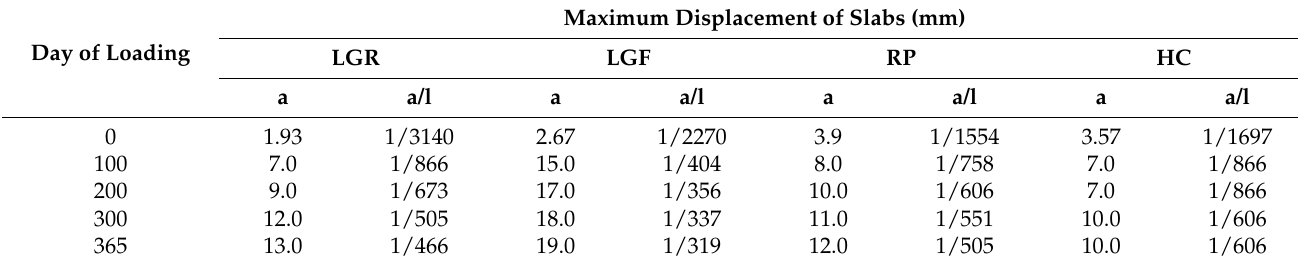
Table 5. Maximum displacements of individual models on consecutive days of loading.